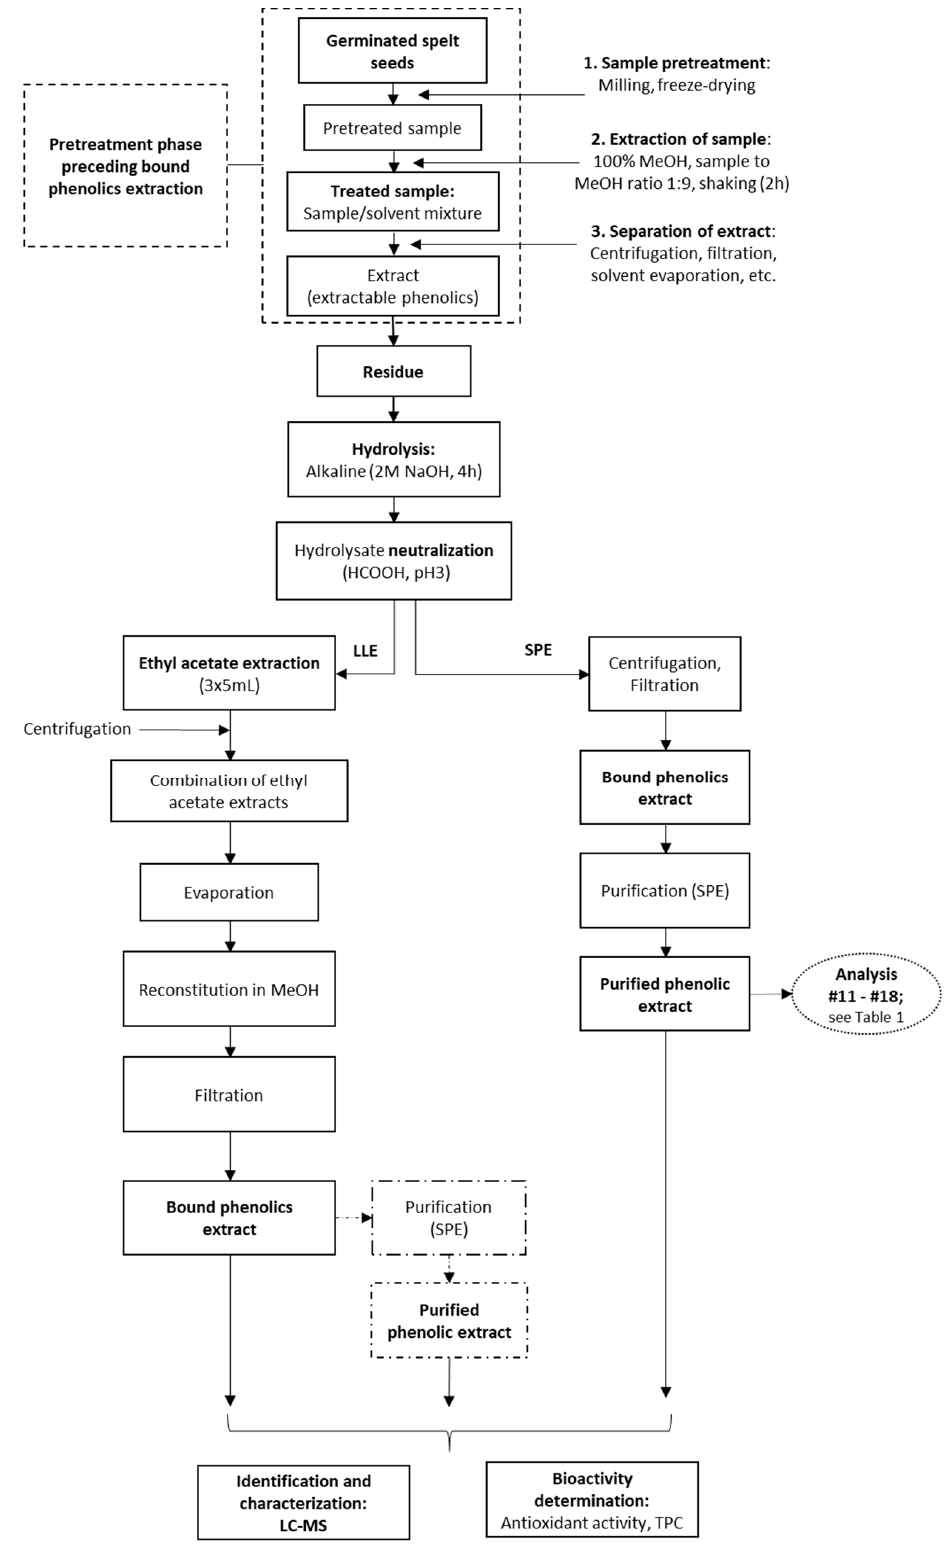
Figure 2. Processing of the germinated spelt ( Triticum spelta ) seeds to obtain the bound phenolics through direct purification by solid-phase extraction (SPE) and through liquid-liquid extraction (LLE) without and with SPE purification. For analyses indicated, see Table 1.